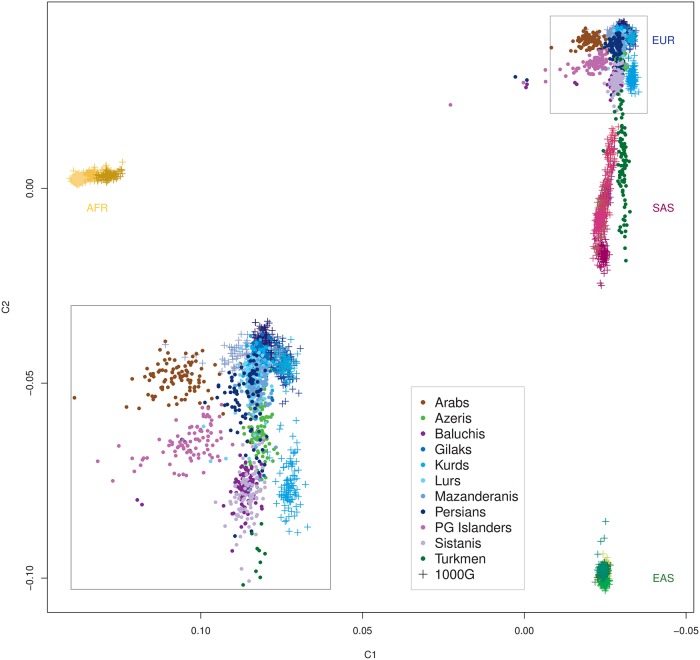
Iranian ethnic groups in a global context.Relative sample locations with respect to the first two MDS components. Iranian ethnic groups in a global context (subset of “Old World” populations from the global 1000G data set); inlet zoomed view of the CIC and adjacent European populations.